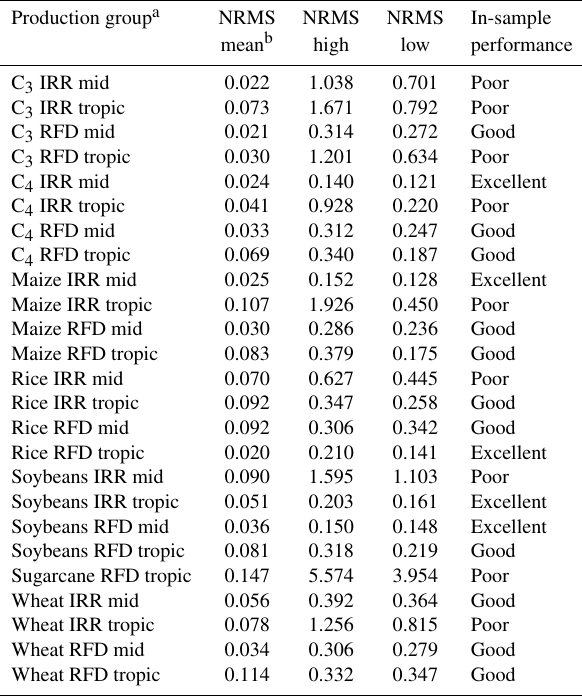
Table A6. Persephone v1.0 response function performance for all production groups, for cross µ CTW (Eq. A3), cubic σ CTW (Eq.